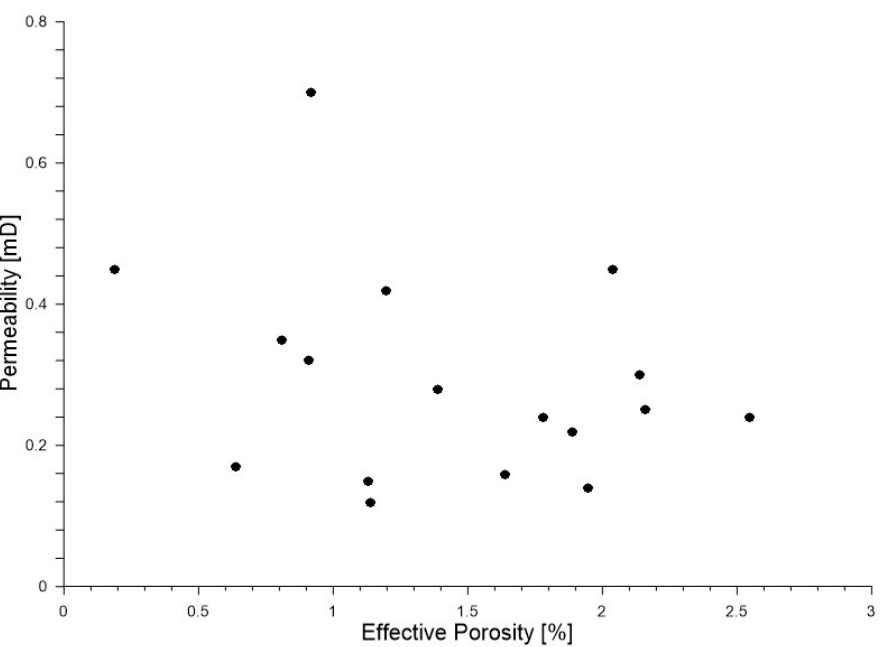
Figure 5. Permeability versus effective porosity cross-plot for samples of quartz sandstones from modeled depth interval of 4716 to 5000 m below surface. Laboratory measurements after Modli ń ski [42].